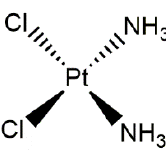
Figure 10. Schematic representation of cisplatin’s chemical structure.